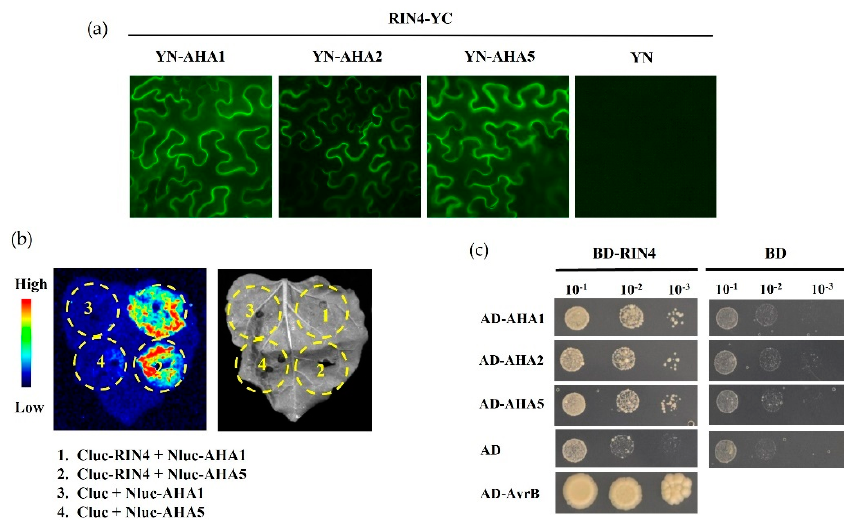
Figure 7. AHA5 interacts with RIN4 in vivo and in vitro. ( a ) Protein interaction between AHA5 and RIN4 by BiFC assay. The full length of AHA1/2/5 was fused with the Nterminus of YFP (YN), while the full length of RIN4 was fused with the C-terminus of YFP (YC). Agrobacterium strains containing the related constructs of AHAs (YN-AHA1, YN-AHA2, and YN-AHA5) and RIN4 (RIN4-YC) were co-infiltrated into N. benthamiana leaves. The empty YN construct (YN) was used as the negative control. The signals were checked 3 days after the infiltration of N. benthamiana leaves. The yellow fluorescent signals indicate the interaction. ( b ) Protein interaction between AHA5 and RIN4 by luciferase assay. The interaction between AHA1/5 and RIN4 was determined by a split luciferase complementation assay in N. benthamiana . Luciferase activities were detected by luminescence imaging with a CCD camera. AHA1/5 and RIN4 were fused with Nluc and Cluc as Nluc-AHA1/5 and Cluc-RIN4. The yellow dotted circles show leaf regions that were infiltrated by the Agrobacterium strains containing the related constructs. The empty Cluc construct (Cluc) was transformed as the negative control. The signals were checked 3 days after the infiltration of N. benthamiana leaves. The signals indicated the interactions. Numbers 1–4 show different combinations of constructs labeled on the right. ( c ) AHAs-RIN4 interactions were detected by the yeast two-hybrid assay. RIN4 (full length) and AHAs (C-termini) were fused with the DNA-binding domain (BD) and activation domain (AD) of the GAL4 transcription factor, respectively. BD-RIN4 and AD-AHAs were co-transformed into yeast cells. Empty AD and BD were used as the negative controls. The RIN4– AvrB interaction was used as a positive control. A series of diluted yeast cells were grown on the synthetic dropout media, which lacked Trp, Leu, and His ( − Trp − Leu − His) and was supplemented with 3-AT. The growth of the yeast cells could indicate the existence of protein